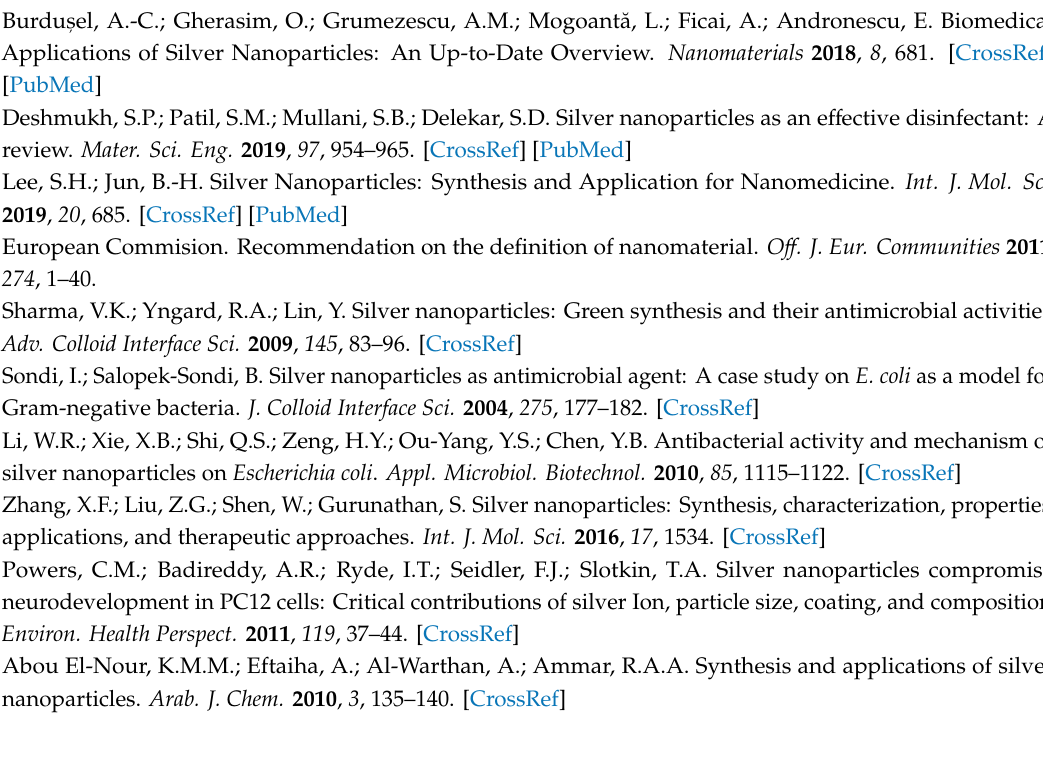
Figure S1: Biofilm forming ability of Pseudomonas and Staphylococcus